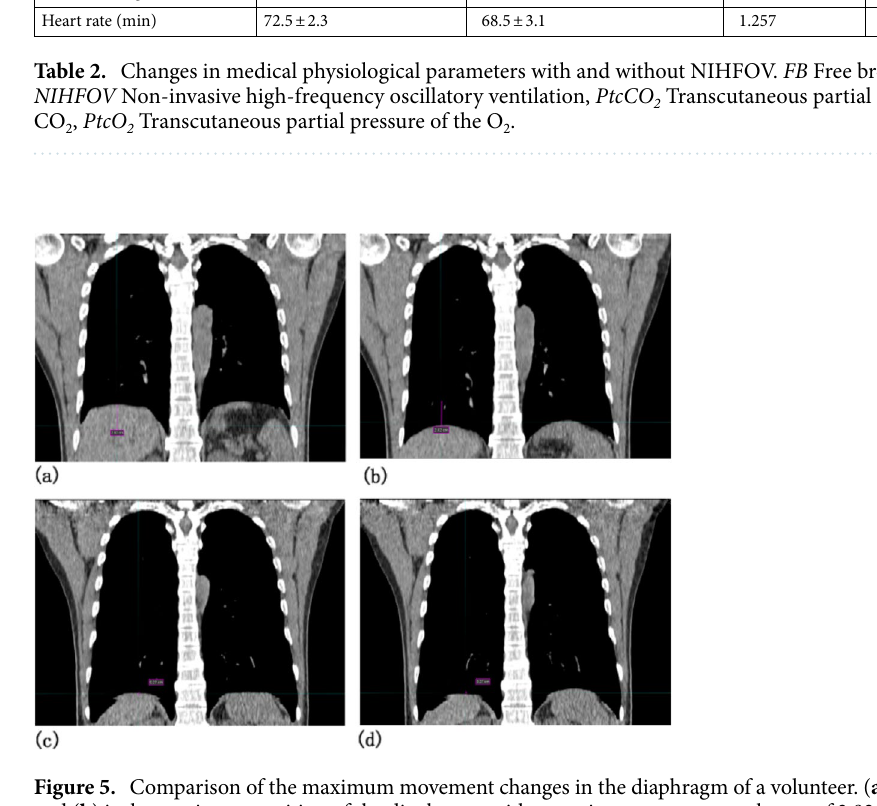
Figure 5. Comparison of the maximum movement changes in the diaphragm of a volunteer. ( a ) The minimum and ( b ) is the maximum position of the diaphragm with a maximum movement change of 2.82 cm in the cephalic-to-caudal direction under FB. ( c , d ) A maximum movement change of only 0.27 cm under